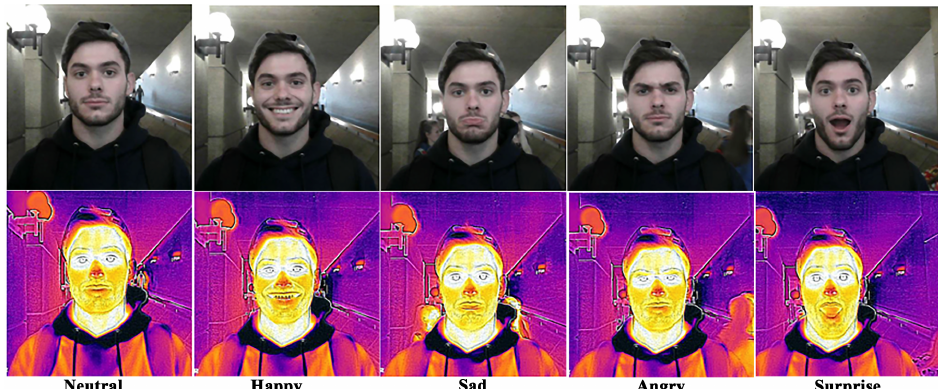
Figure 4. Sample image of a subject showing all five emotions in visible and MSX format in the proposed VIRI DB.